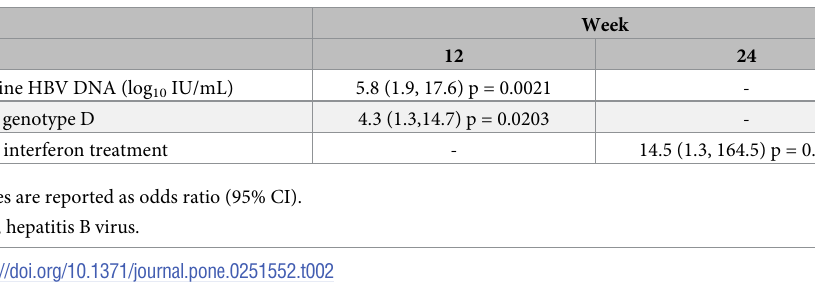
Table 2. Multivariate analysis: Predictors of HBV DNA � 200,000